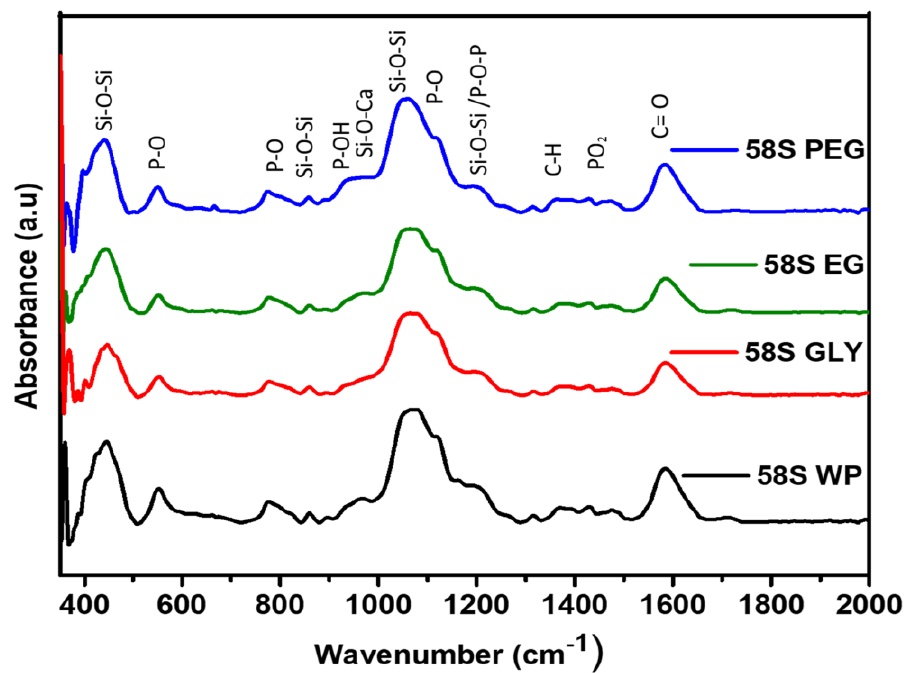
Figure 3. FT-IR spectra of 58S WP, 58S GLY, 58S EG, and 58S PEG sols heat-treated at 160 ° C/1 h.